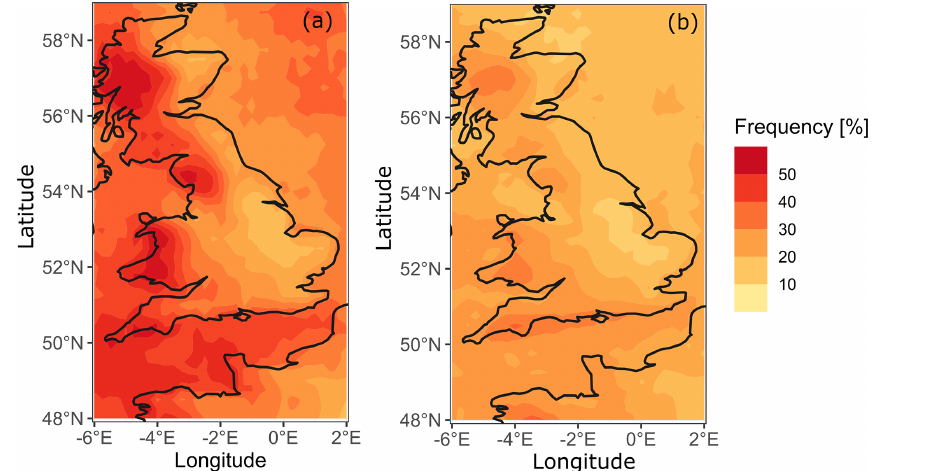
Figure A2. Compound hazard (wind–precipitation) cluster proportion among (a) wind clusters and (b) precipitation clusters during the period 1979–2019 in Great Britain. Data from ERA5 (Hersbach et al., 2018).